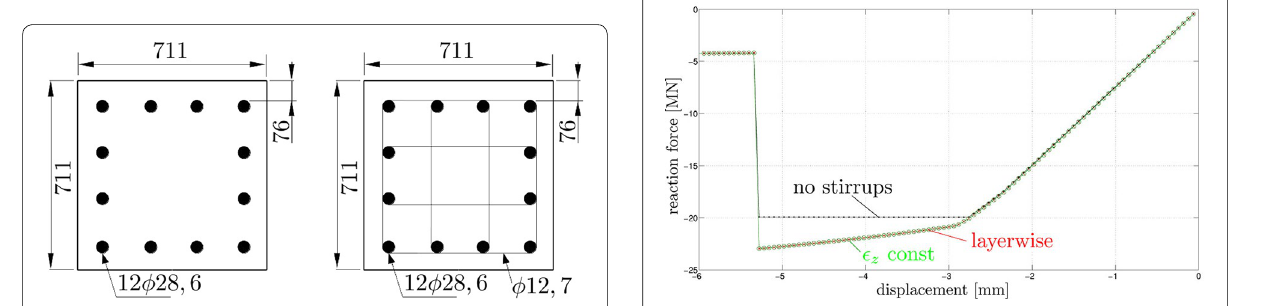
Fig. 5 Cross sections of the columns with and without strirrups used in Lew et al. (2011) (unit: mm).